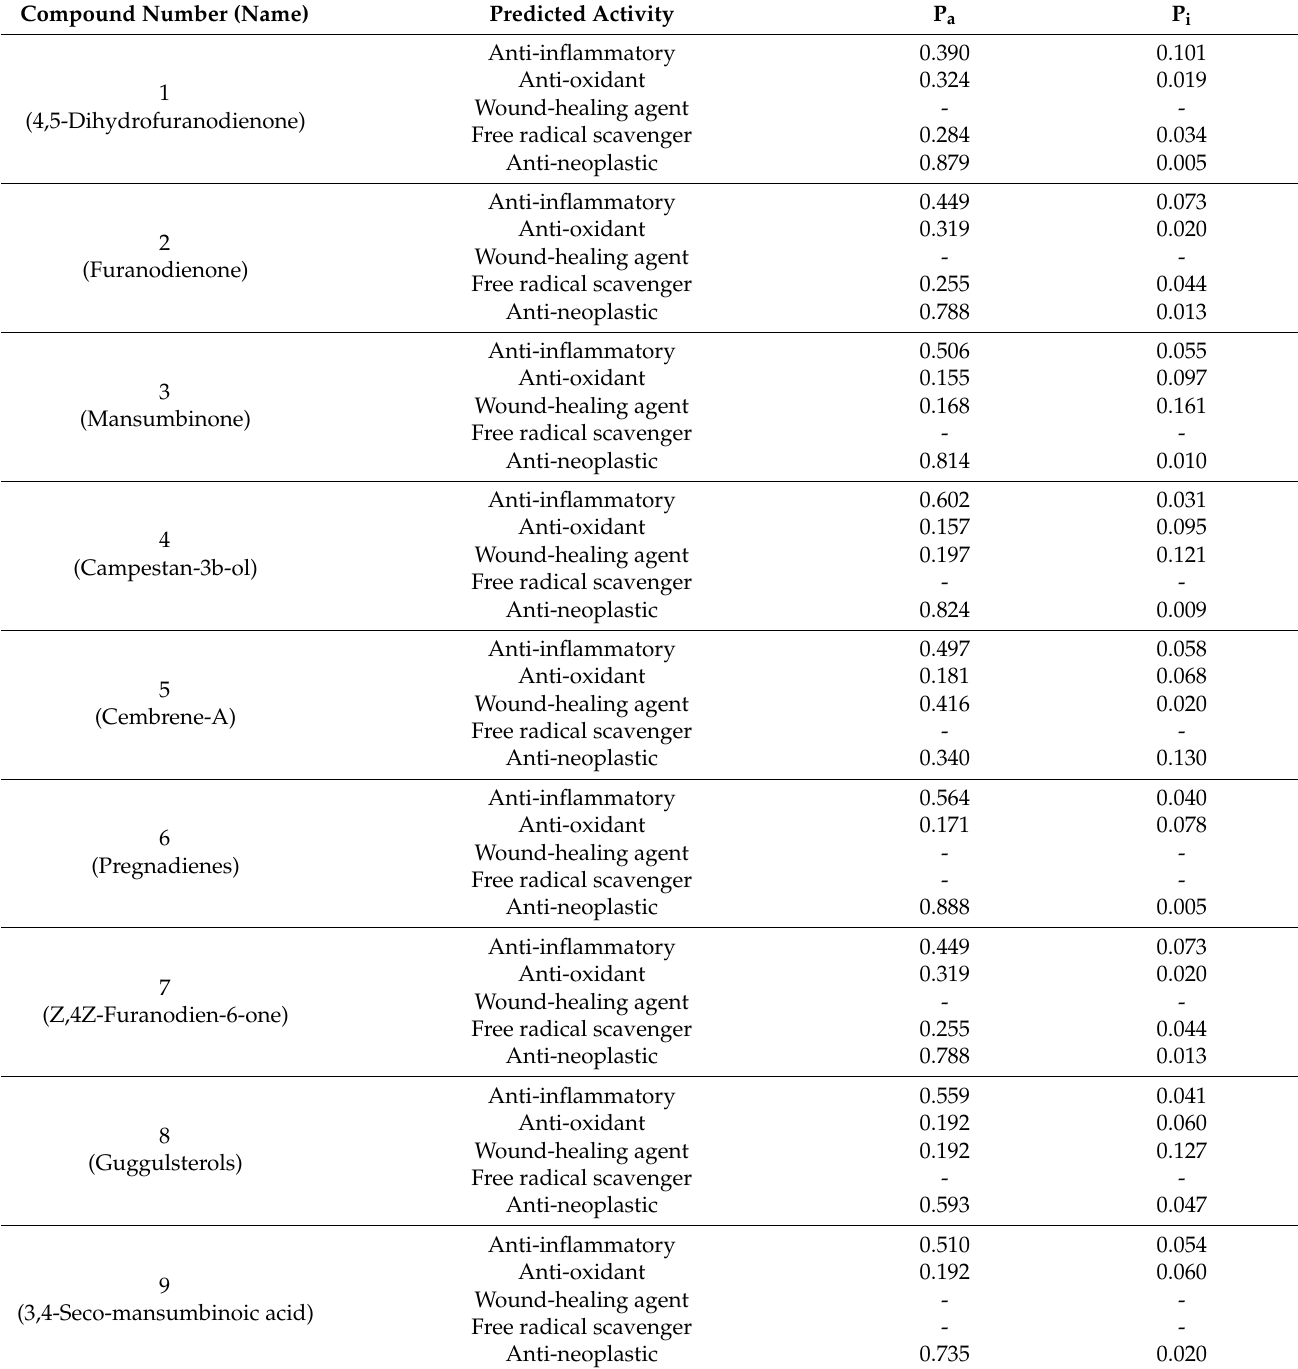
Table 3. Prediction of biological activity of myrrh methanolic